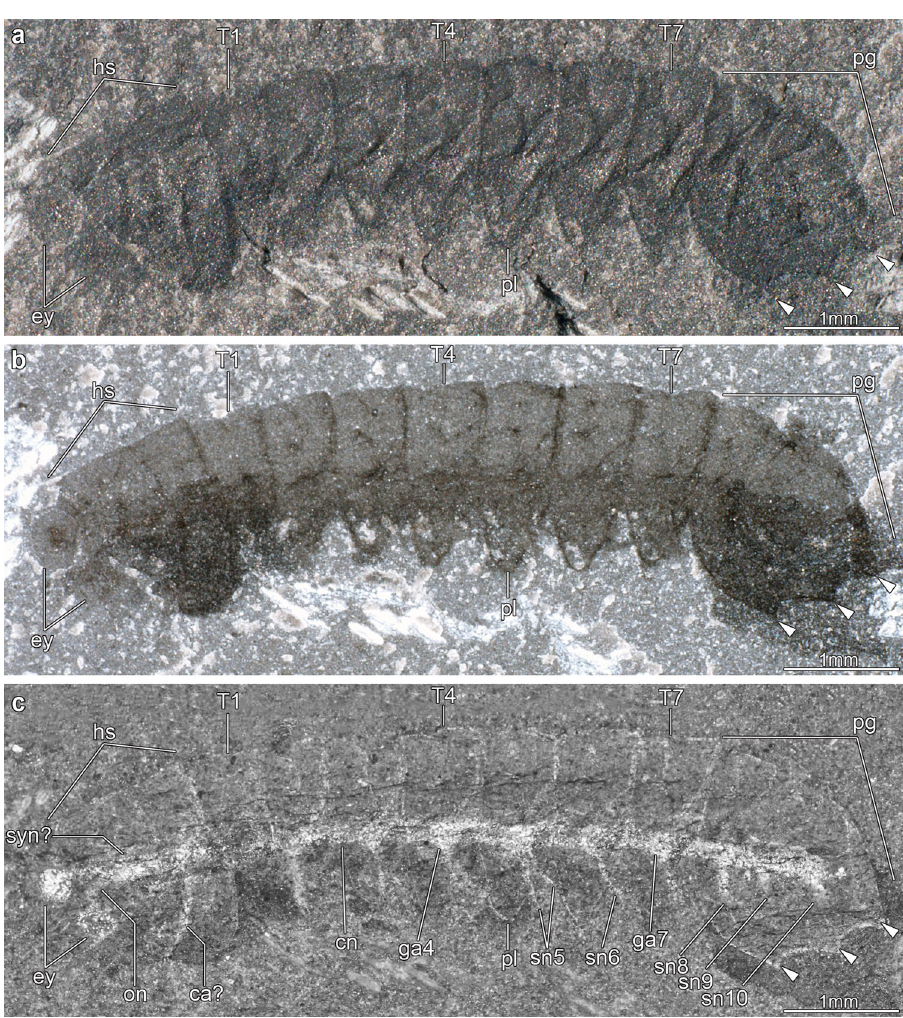
Fig. 3 Central nervous system preservation in Mollisonia symmetrica from the Cambrian (Wuliuan) Burgess Shale, Walcott Quarry. a USNM 305093, photographed dry with low angle re fl ected light to enhance topographic information; arrowheads indicate the position of spines in the pygidium. b USNM 305093, photographed dry with cross-polarized illumination to enhance specimen outline. c USNM 305093, photographed underwater with cross- polarized illumination to highlight morphology of central nervous system. ca? putative cephalic appendage, cn connective, ey lateral eye, ga n segmental ganglion, hs head shield, on optic nerve, pl pleura, pg pygidium, sn n segmental nerve, syn? putative synganglion, T n trunk